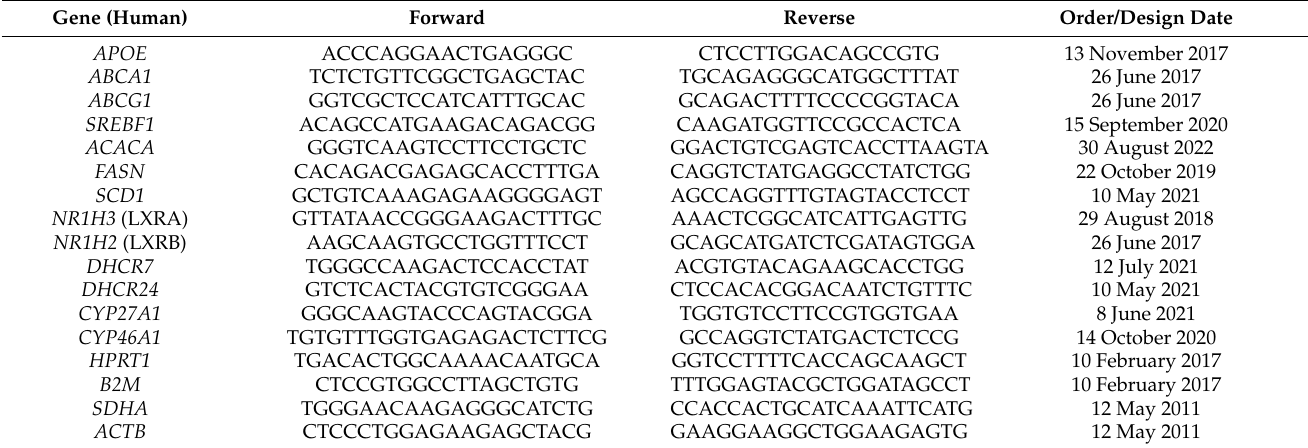
Table 2. Sequence of the primers used for quantitative